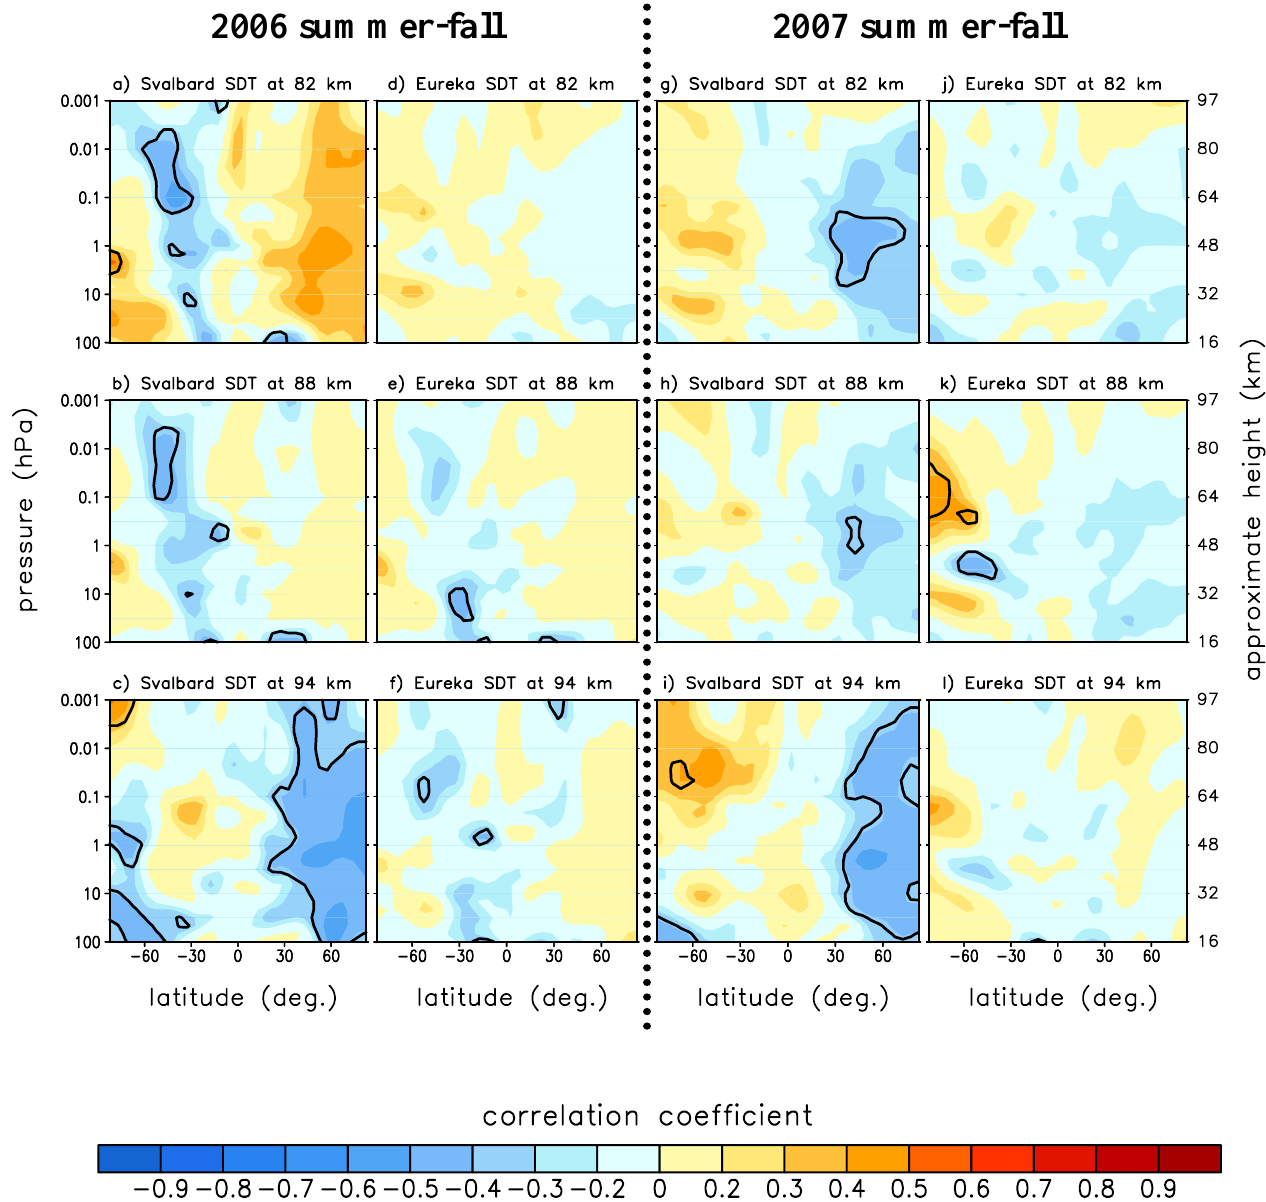
Fig. 1. Correlation coefficients between the stationary planetary wave 1 amplitude at each latitude/pressure with the amplitudes of meridional semidiurnal tides observed at Svalbard (78 ◦ N, 16 ◦ E) and Eureka (80 ◦ N, 86 ◦ W) for 30 June–27 October, 2006 and 2007. The tidal amplitude sequence is kept constant for each contour plot. From top to bottom the tidal heights are 82, 88 and 94km. The black lines indicate a 95% level of